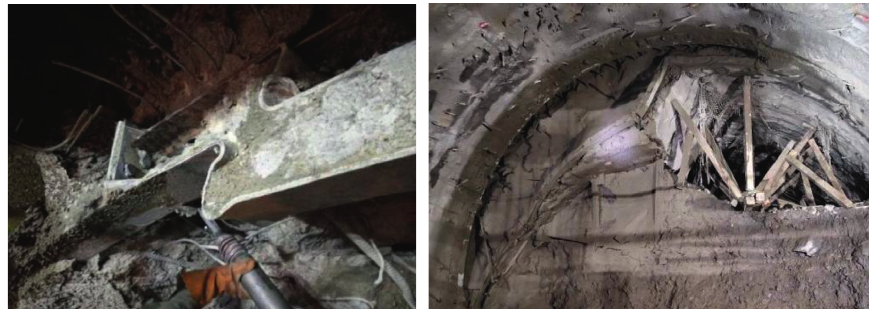
Figure 1: Splitting of primary lining and exceeding clearance